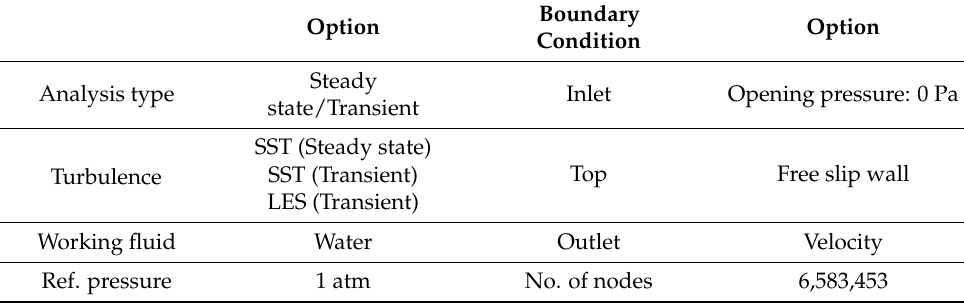
Table 2 summarized details of the CFD setup used in this study. Table 2. Summary of CFD